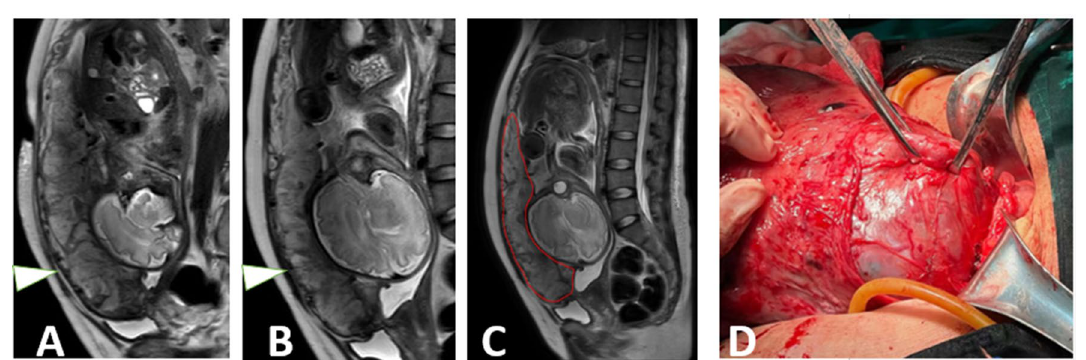
Figure 3. A 38-year-old gravid woman with pernicious placenta previa at 35.1 GW. The normal interface (arrowhead) between normal ( A ) and increta ( B ) placental interface were displayed on sagittal T2WI. The computerized model automatically drew the contour of placenta and gave the prediction probability of 0.937 in placenta increta ( C ). The surgical findings showed the perforating vessels along the uterine serosa ( D